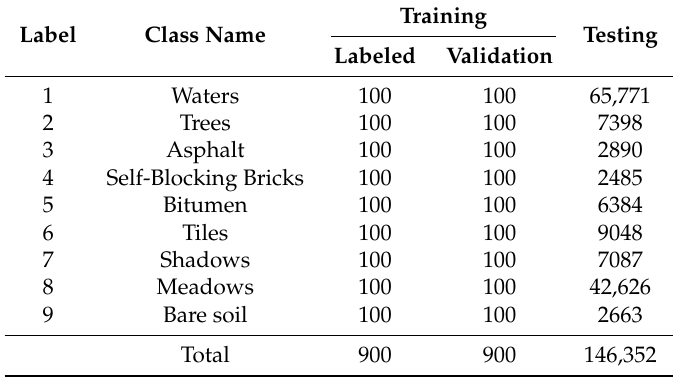
Table 2. Number of training and testing samples in Pavia Center dataset.